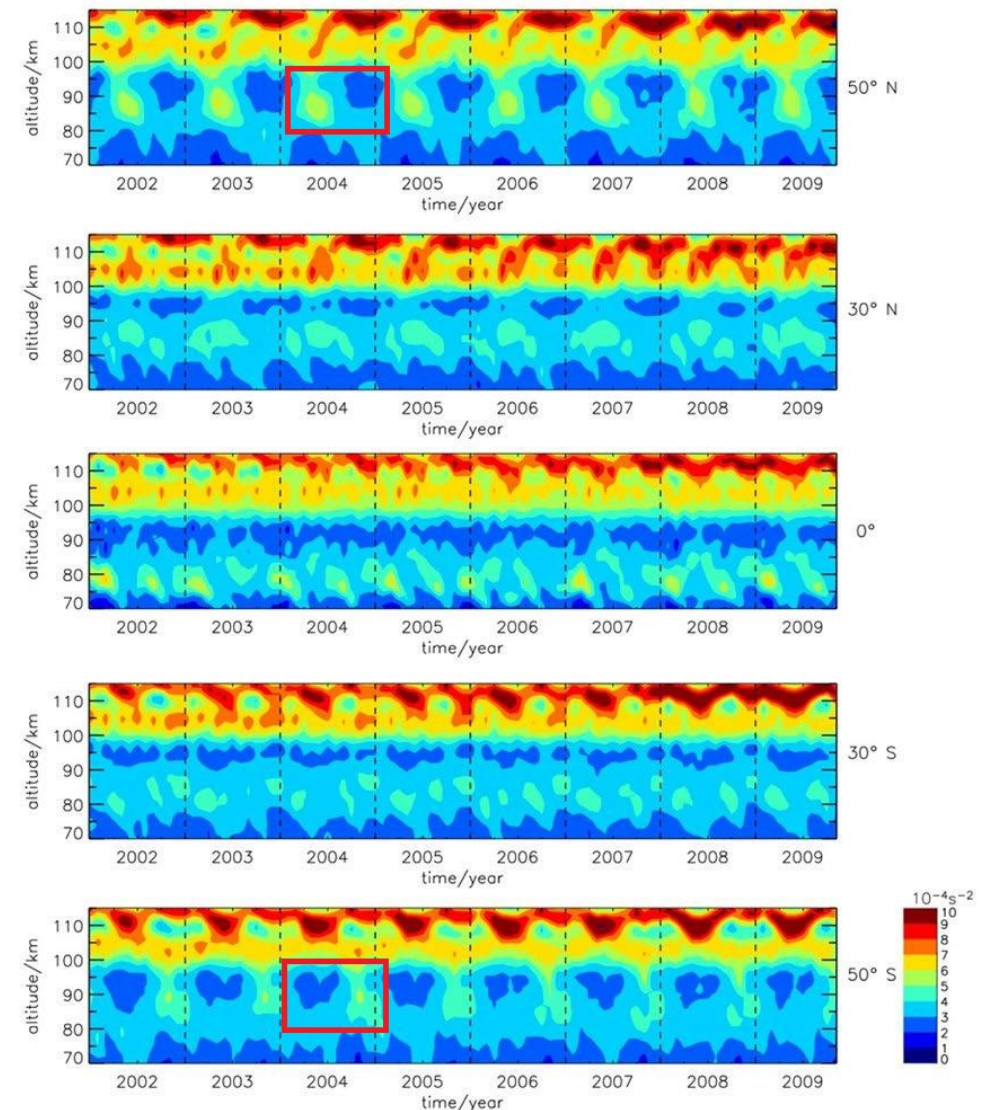
Figure 8. Distribution of the Brunt–Vaisala frequency along with altitude and latitude in 2002–2009 (see also Figure 3.7 in [23]).